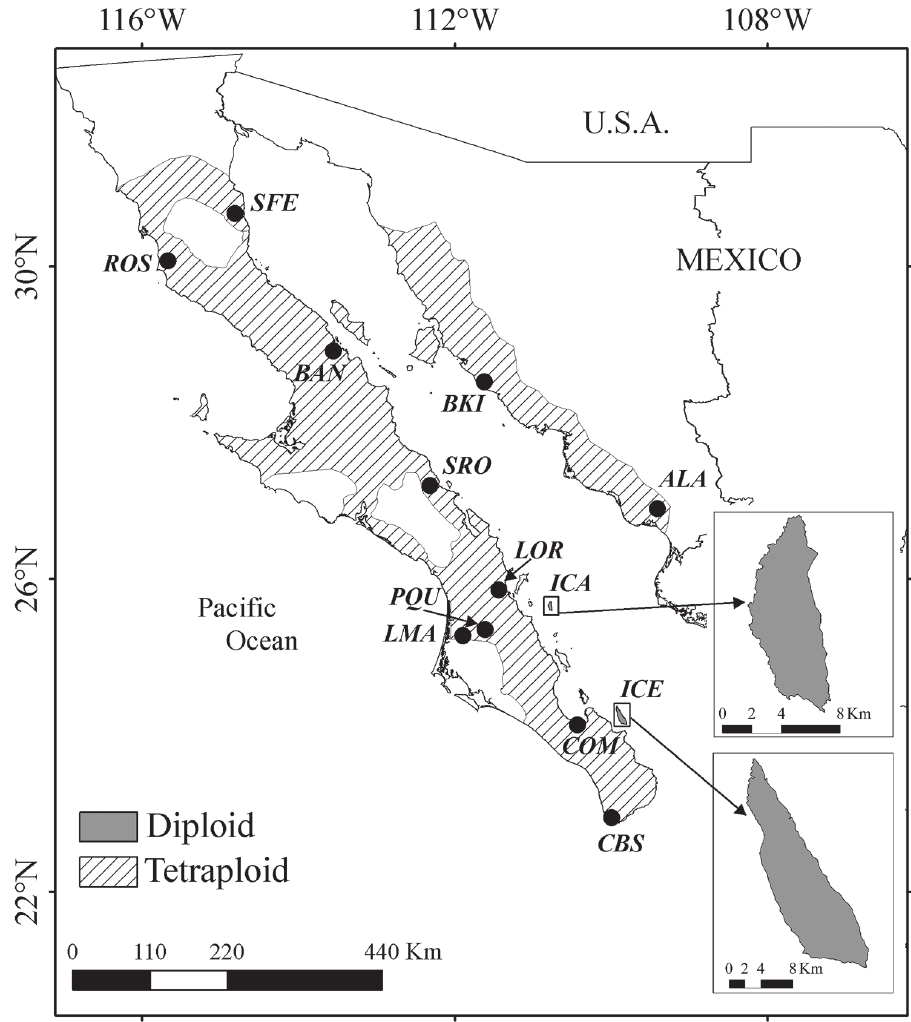
Figure 3. Distribution of diploid and tetraploid individuals in populations (black dots) of Pachycereus pringlei . Dark gray areas in ICA and ICE indicate distribution of diploid (2n = 22) cytotypes. Diagonal shaded area indicates the predicted coverage of tetraploid (2n = 44) cytotypes. See Table 1 for full names of the abbreviated localities indicated in the